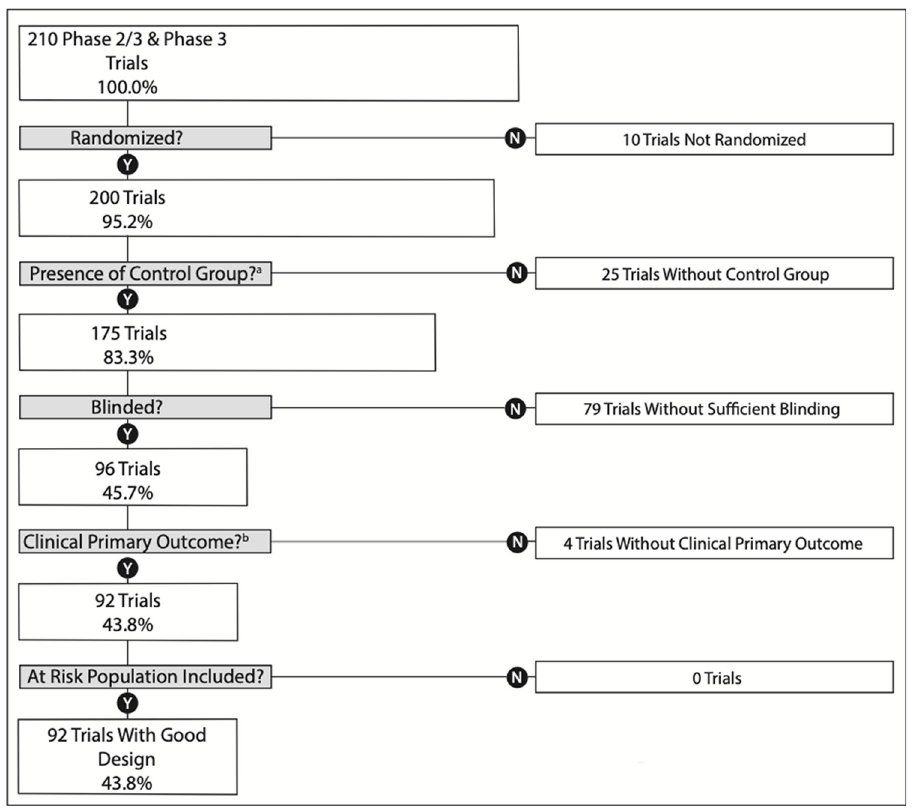
Fig 1. Flow diagram for trial design quality of Phase 2/3 and Phase 3 SARS-CoV-2 trials. a) Refers to trial that is either placebo-controlled or has a standard of care comparator arm. b) Refers to a treatment trial with a clinical primary outcome or a prevention trial with either a clinical primary outcome or laboratory-confirmed SARS-CoV-2.